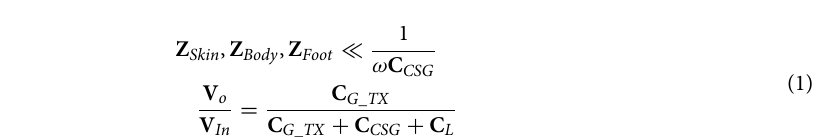
Figure 3. Comparison between Animal Body Communication and Human Body Communication circuit